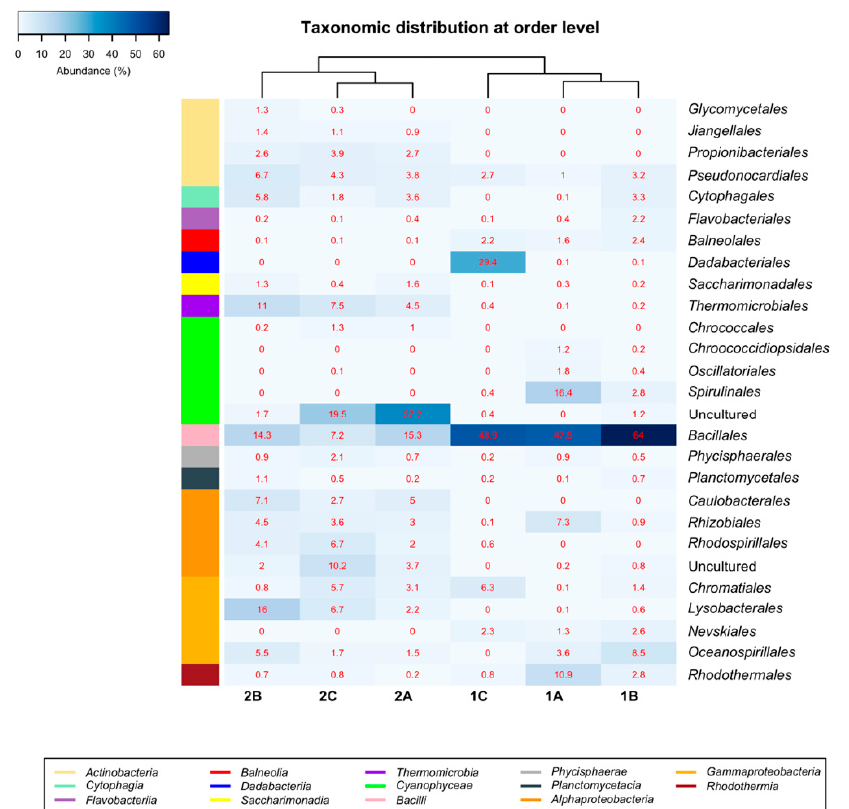
Figure 4. Heat-map analysis of Nerja Cave biofilms. Taxonomic identifications of Bacteria at order level. The orders are described in the right column and their respective abundances included in the boxes.